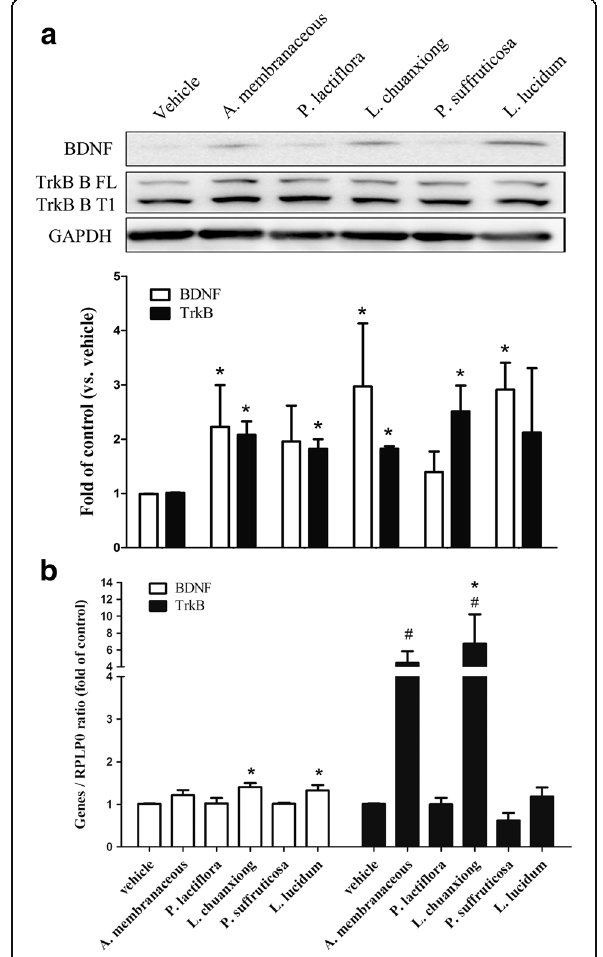
Fig. 4 Effects of the various Chinese herbal extracts (CHE) on the gene expression levels of the BDNF autoregulation loop using MDA- MB-231 line. Cultured MDA-MB-231 cells without/with each CHE individual (1 μ g/mL for each herbal extract) pretreatment were lysed and the gene expression levels of BDNF and TrkB at both the protein and mRNA level were analyzed by Western blot ( a ) and real-time PCR ( b ), respectively. Data are expressed as mean + SEM. *, p < 0.05 compared to vehicle group by Mann-Whitney U test (n = four or five independent experiments in each